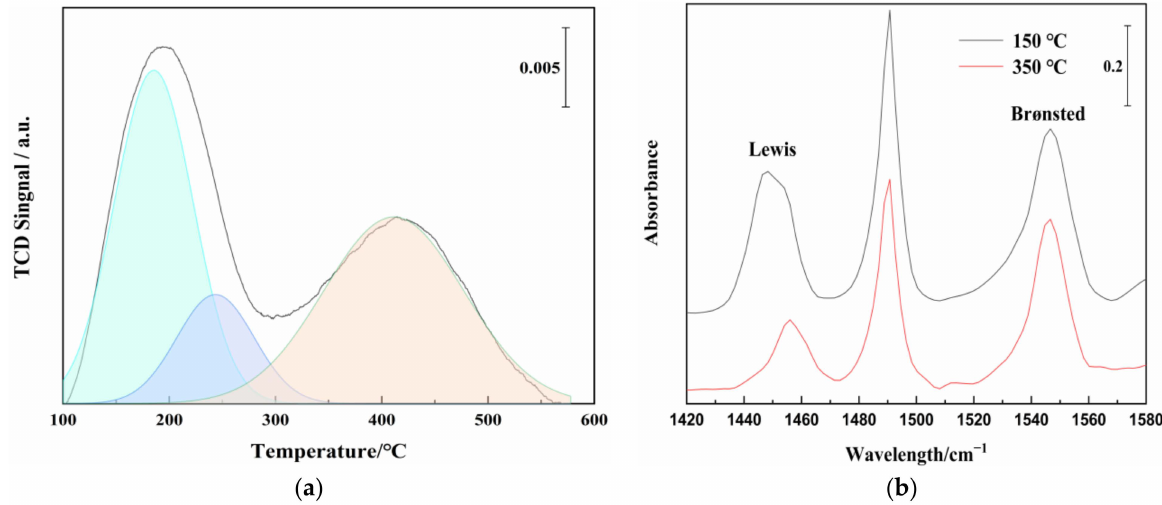
Figure 3. NH 3 -TPD profiles for HZSM-5 ( a ); Py-FTIR spectra of HZSM-5 ( b ).